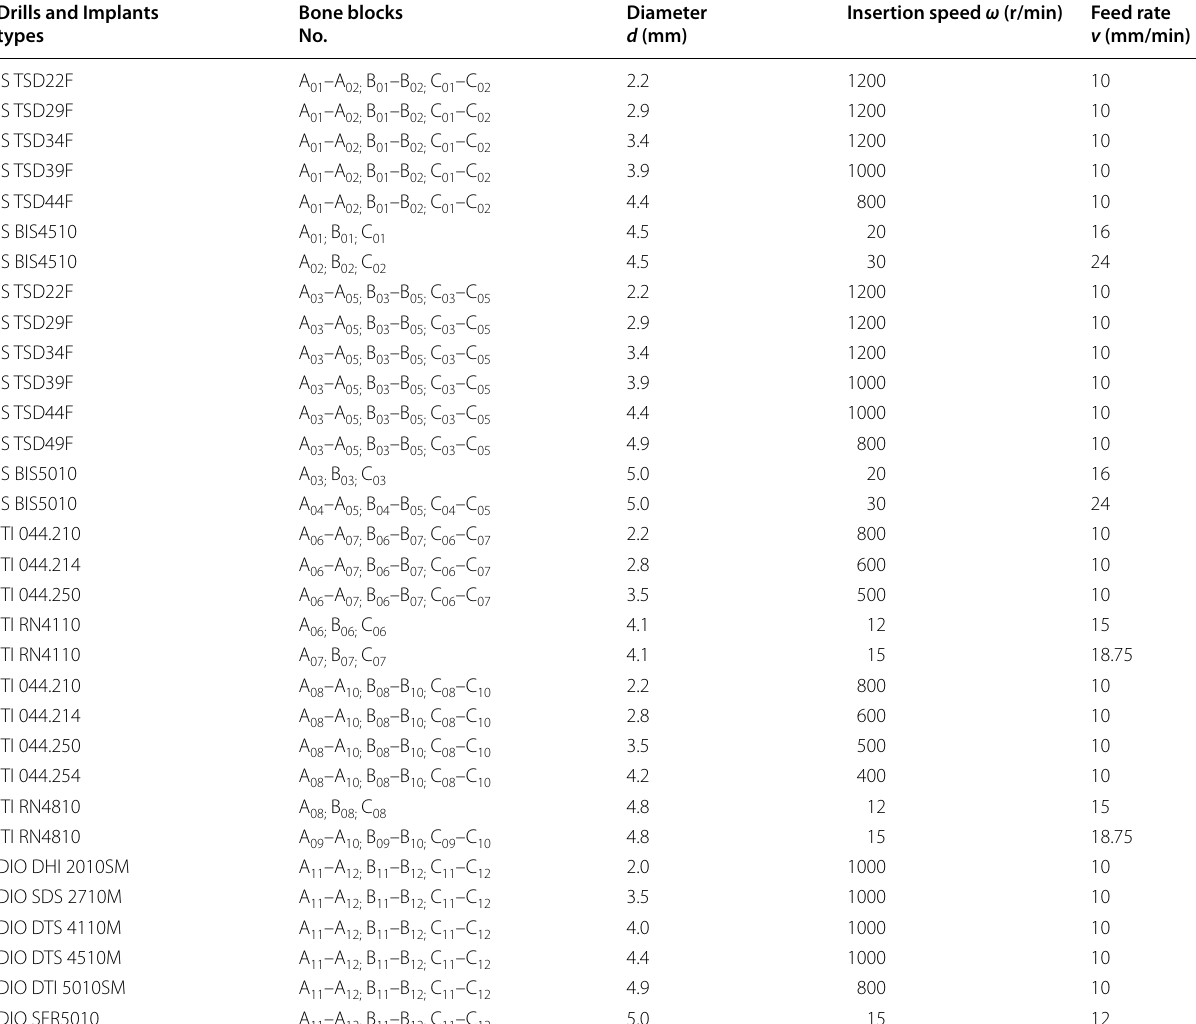
Table 3 Parameters of insertion experiments Drills and Implants types